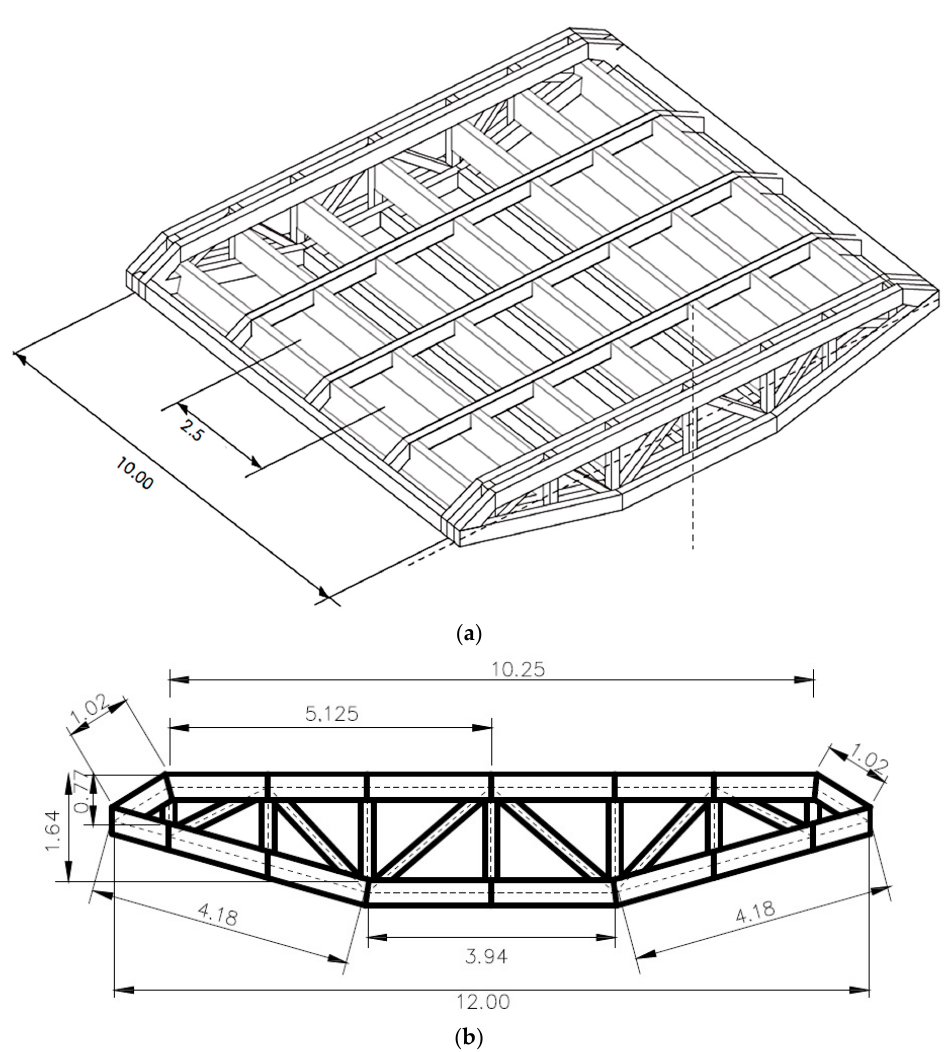
Figure 8. Deck structure: axonometric three-dimensional view ( a ) and cross-section view ( b ).